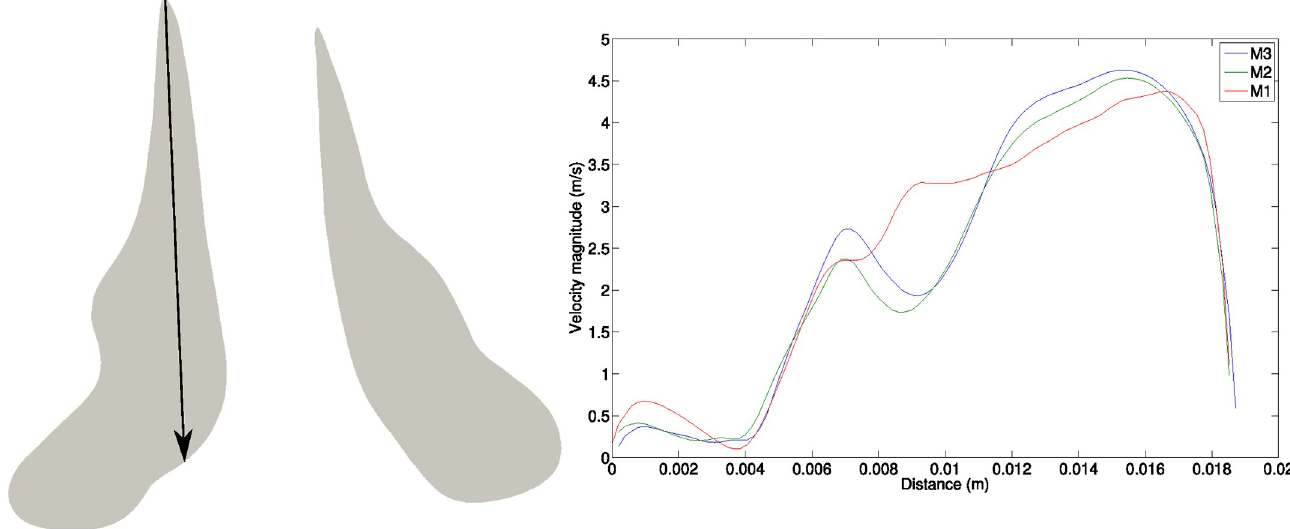
Fig 6. Time average velocity magnitude profile with different mesh resolutions at the sagittal plane on the slice located at 16 mm distal from the nostril on an arbitrary line ( Q = 57.4 L / min max